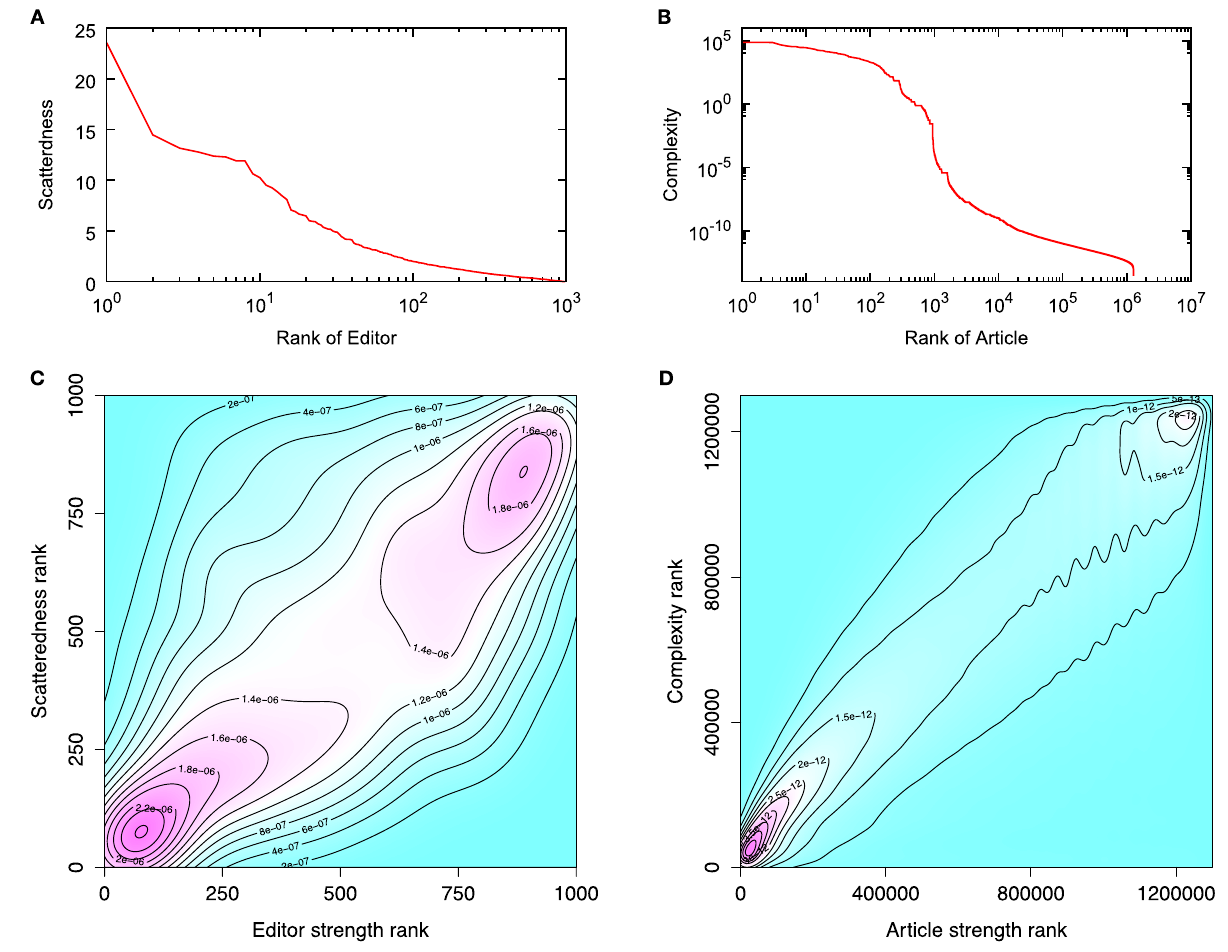
Figure 1. The distribution of the scatteredness of editors and the complexity of articles calculated from the self-consistent measures in Eqs. (3, 4). ( A ) The rank plot of the scatteredness of editors, ( B ) the rank plot of the complexity of articles, ( C ) the density distribution of editors in the rank–rank plot of the strength s ǫ = and the scatteredness, and ( D ) the density distribution of articles in the rank-rank plot of the strength = s w α ǫα and the ǫ (cid:31)